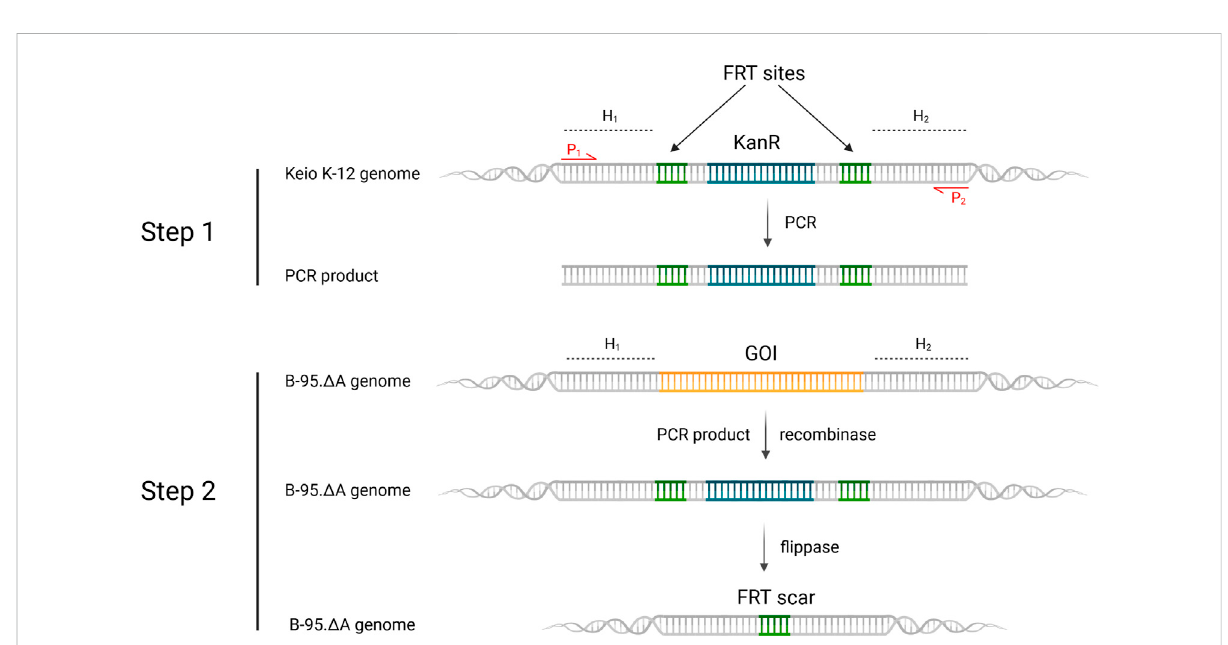
FIGURE 6 Revised lambda red recombineering work fl ow for gene deletions leading to the generation of the sextuple E. coli knockout strain B-95. Δ A NK53. H 1,2 = homology region 1 or 2; P 1,2 = Primer 1 or 2; KanR = kanamycin resistance cassette; GOI = gene of interest, which is targeted for deletion. Step 1 displays the PCR-ampli fi cation of the FRT-KanR-FRT-cassette from the Keio knockout strain. Step 2 depicts the recombinase induced replacement of the gene of interest with the FRT-KanR-FRT-cassette and its subsequent fl ippase catalyzed removal. Created with